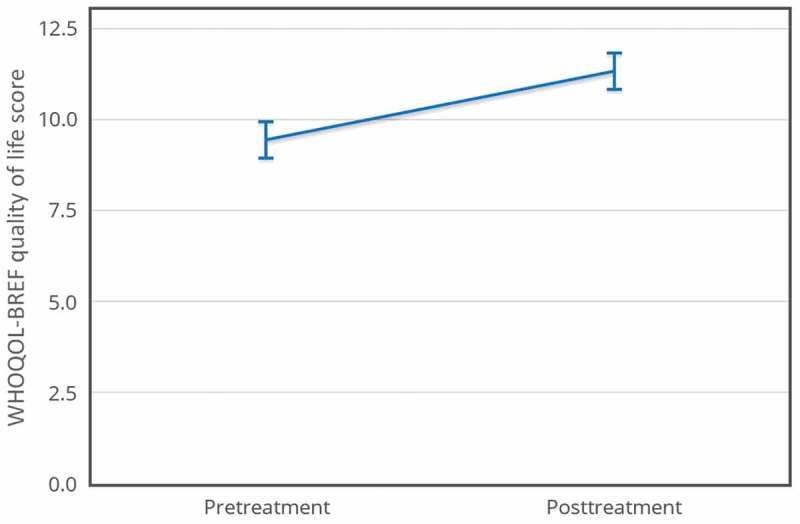
WHOQOL-BREF quality of life, N = 17.